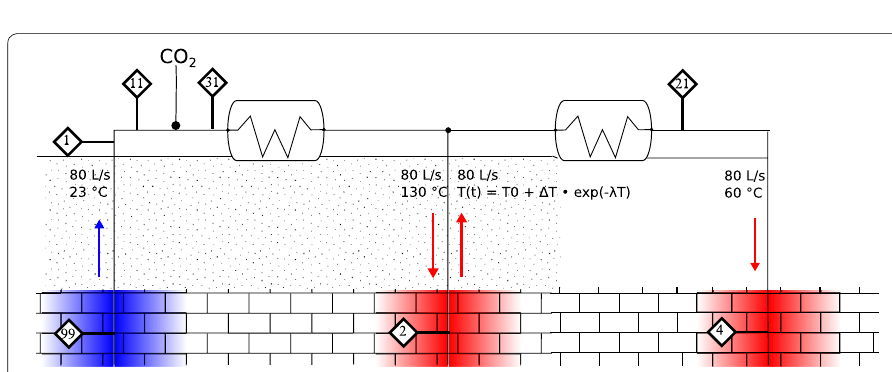
Fig. 5 Conceptual model of an ATES as triplet system including simulation